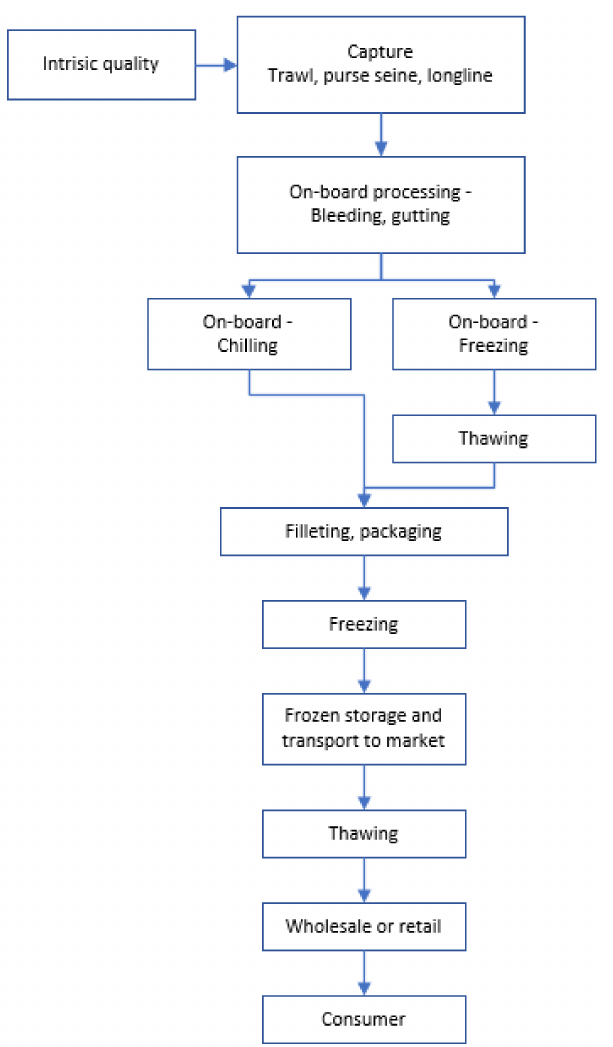
Figure 1. The freeze-chilling value chain for whitefish showing the involved steps from sea to consumer. Frozen storage may take place at plant before transport to market for off-season marketing or continued near market until thawing, that is, consumer packages can be made at plant or